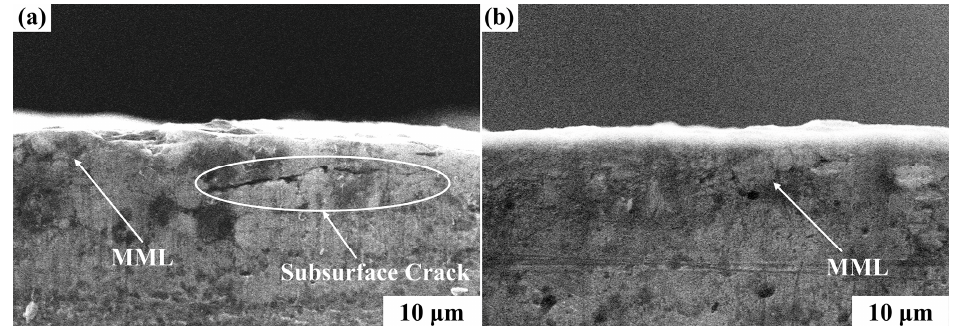
Figure 5. Cross sections normal to the worn surface of ( a ) Al-Cu matrix alloy and ( b ) 0.5 wt.% nano-sized TiC p /Al-Cu composite at 180 °C under 20 N load.